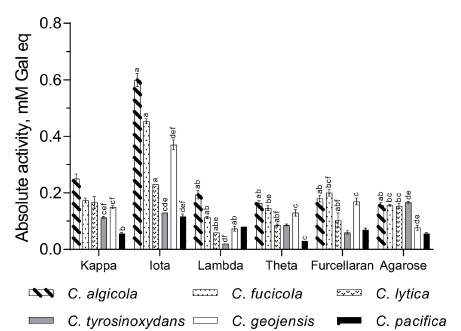
Figure 2. Substrate specificity of crude enzymes from the different Cellulophaga species and absolute activity as the galactose concentration (mM) equivalent. Values are expressed as mean ± SEM (n = 4); Data comparison was performed against different substrates. a = when compared with kappa carrageenan, b = when compared with iota carrageenan, c = when compared with lambda carrageenan, d = when compared with theta carrageenan, e = when compared with furcellaran, f = when compared with agarose. Different lowercase letters on the bars indicate statistically significant differences from respective group using ANOVA, followed by the Tukey’s comparison test ( p <